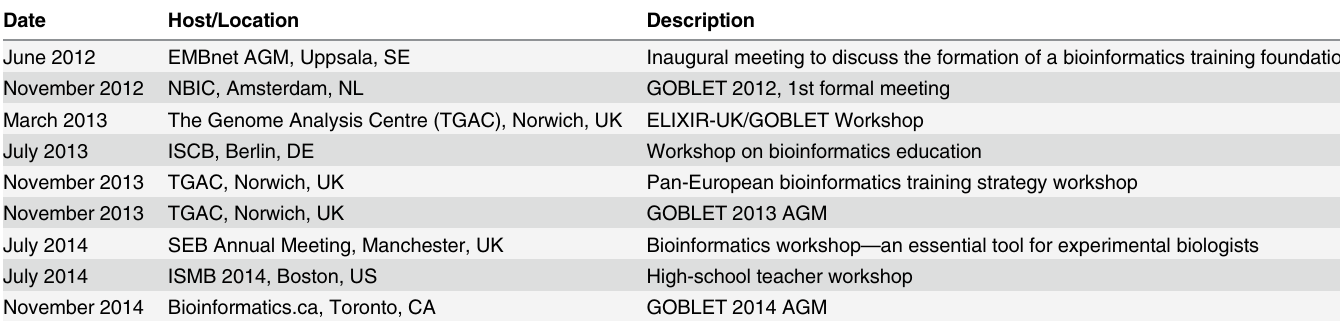
Table 1. GOBLET meetings and